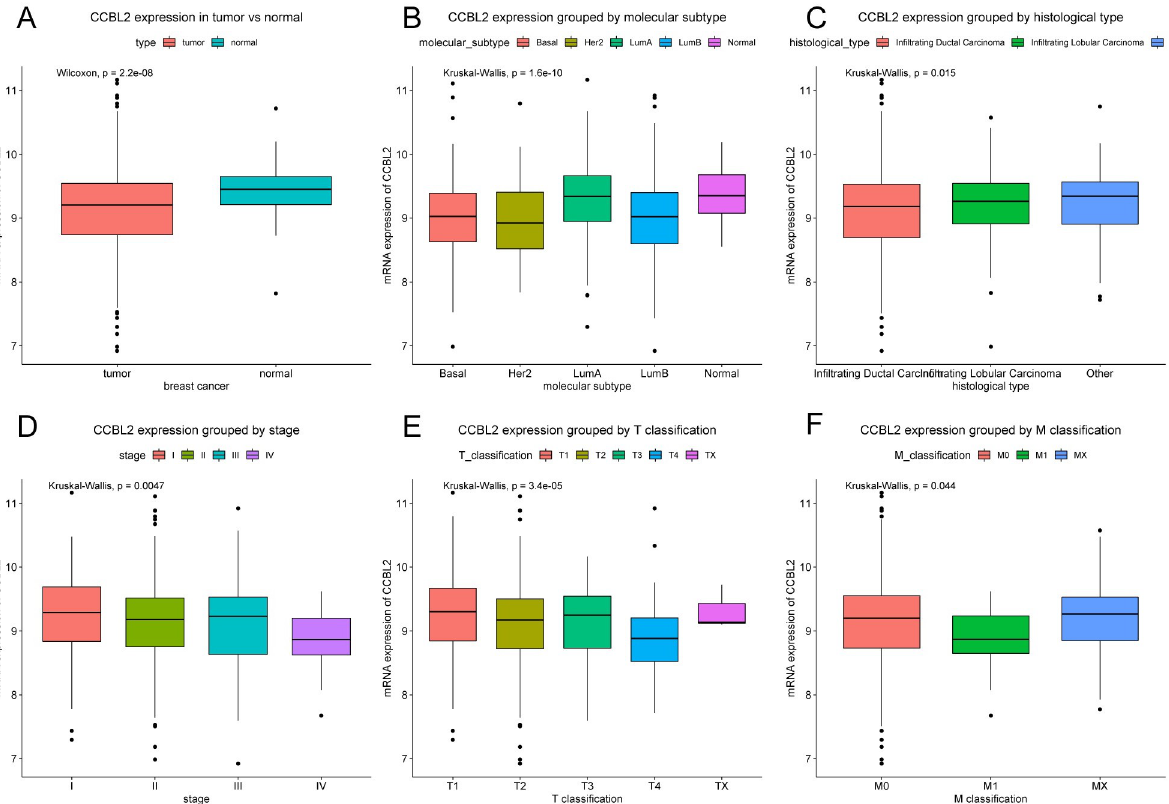
Fig 3. Differences in CCBL2 expression shown in boxplots. The subgroups included type (A), molecular subtype (B), histological type (C), clinical stage (D), T classification (E), and M classification (F). (p < 0.05).